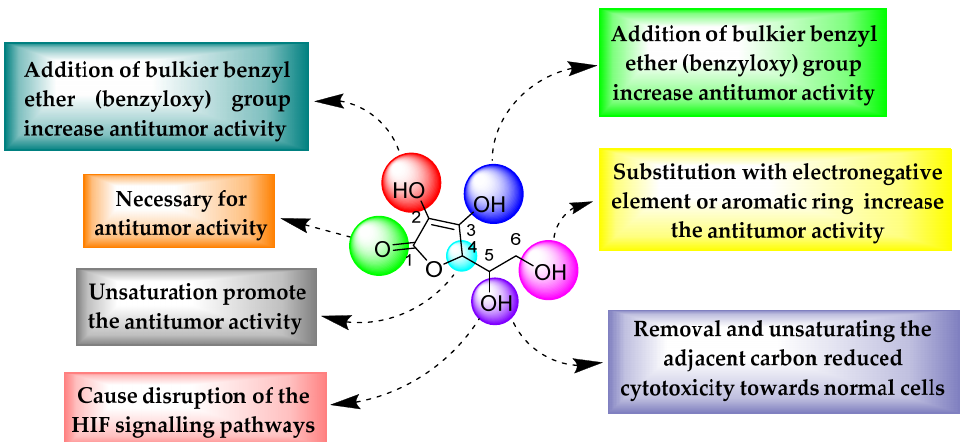
Figure 11. Important structural features of ascorbic acid analogues showing antitumor effects.